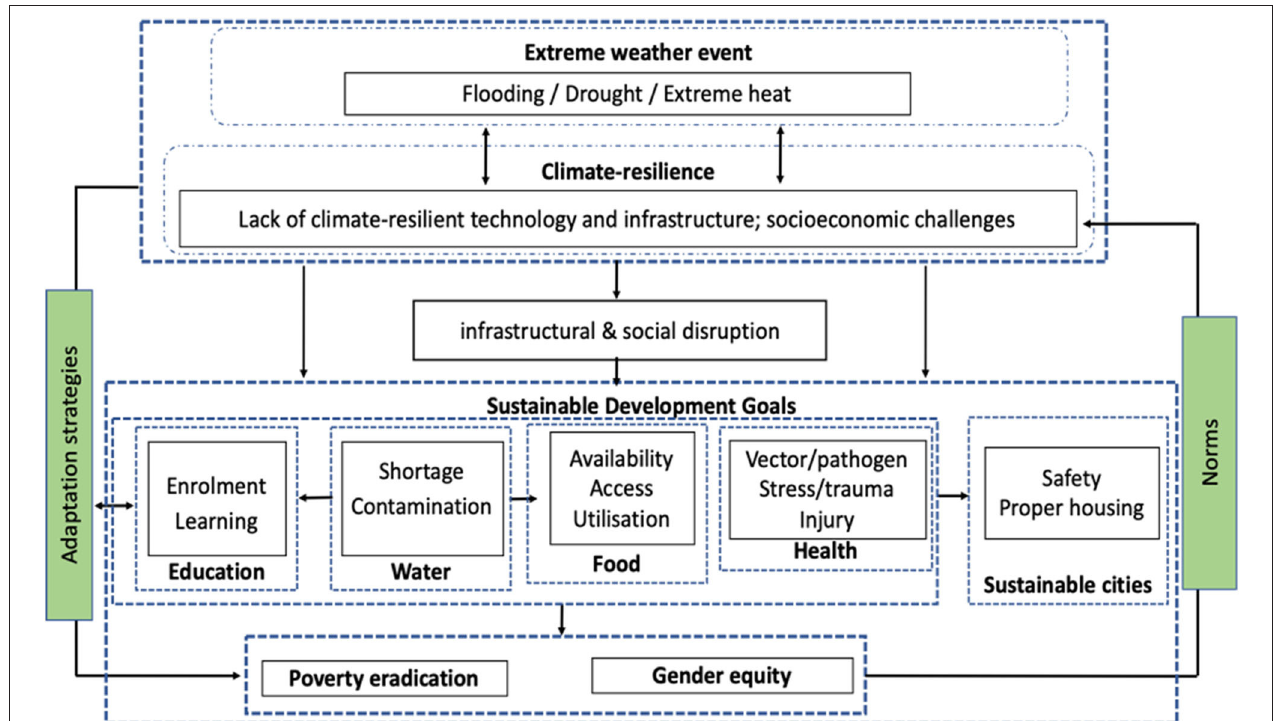
FIGURE 1 | Links between extreme weather events and sustainable development goals. Source: Authors’ construct.